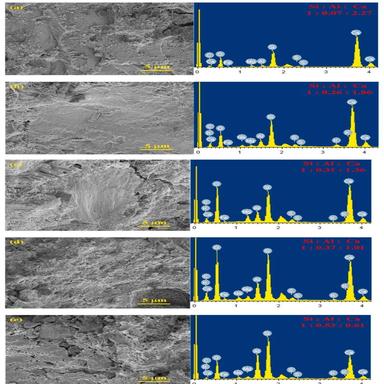
SEM/EDS of composite paste with different CSNGS contents, (a) cement (b) CSNGS-10 % (c) CSNGS-30 % (d) CSNGS-50 % (e) CSNGS-75 %.